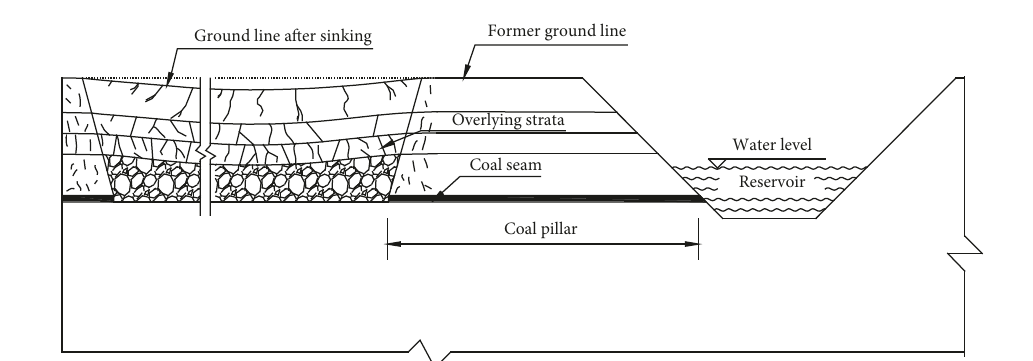
Figure 1: Location of the 4 − 2 coal seam relative to the reservoir.